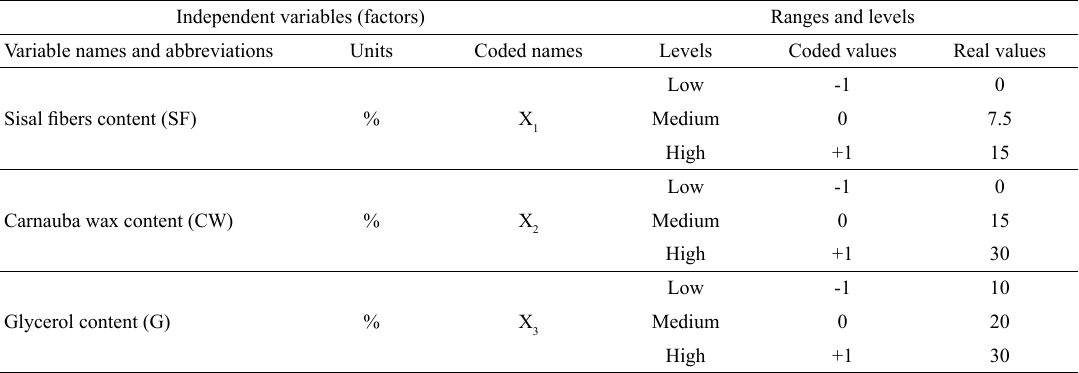
Table 1 . Experimental ranges and levels of the independent test